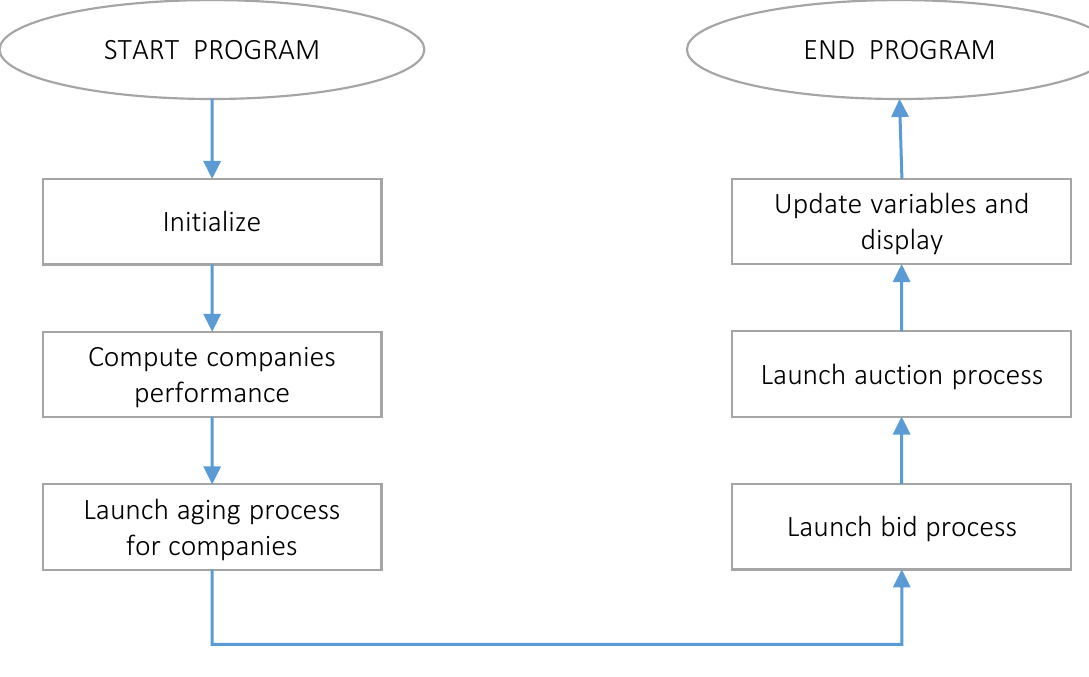
Figure 4. Flow chart of the main program